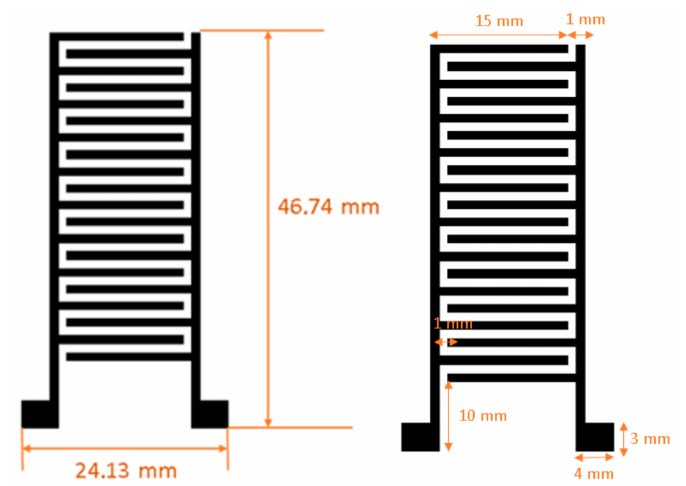
Figure 2. Dimensions of the humidity sensor